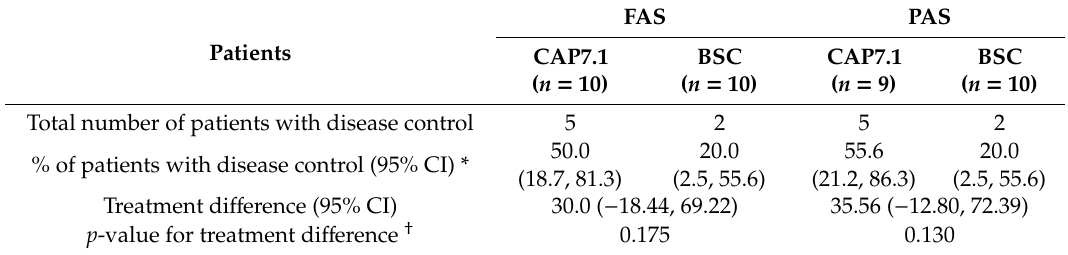
Table 3. Primary endpoint: disease control rate in the FAS and PAS patient